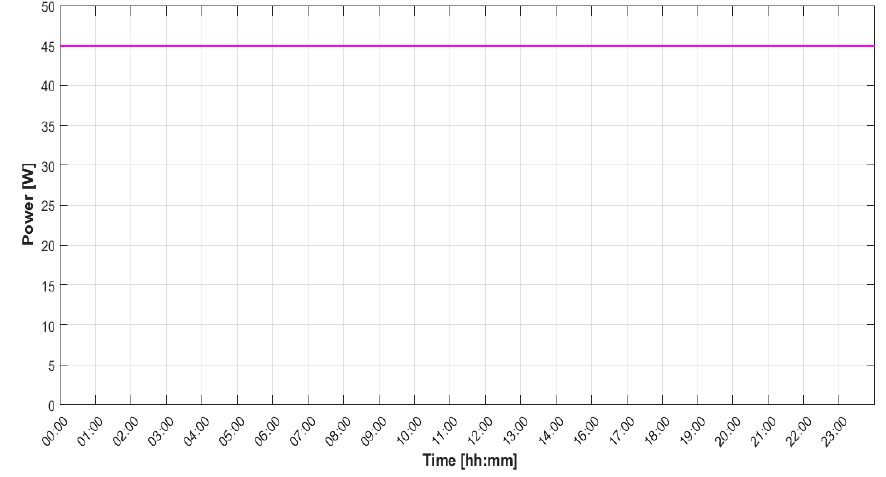
Figure 5. Load curve of the video surveillance system.